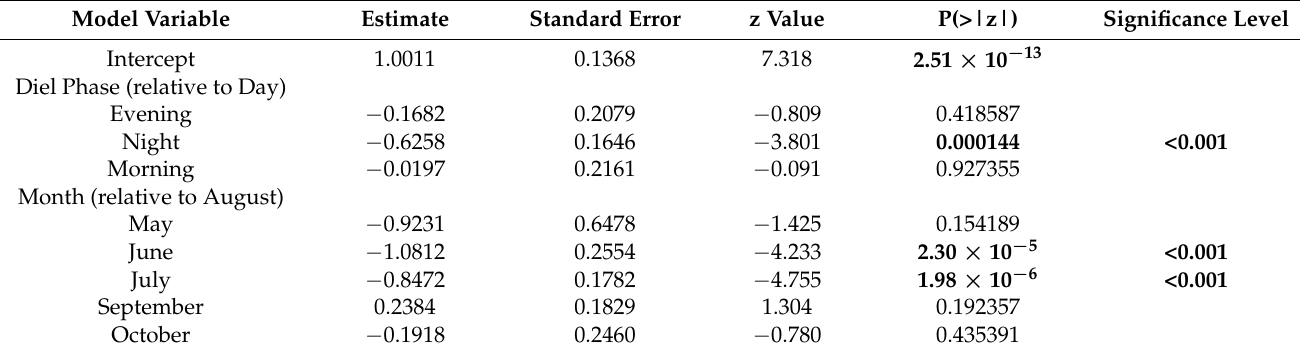
Table 4. Binomial GLM output (Foraging Positive Hour (FPH)-based analysis of dolphin foraging in Brandon Bay). The output shows the estimate, standard error, z value and p -values for each predictor. Significant predictors are highlighted in bold.